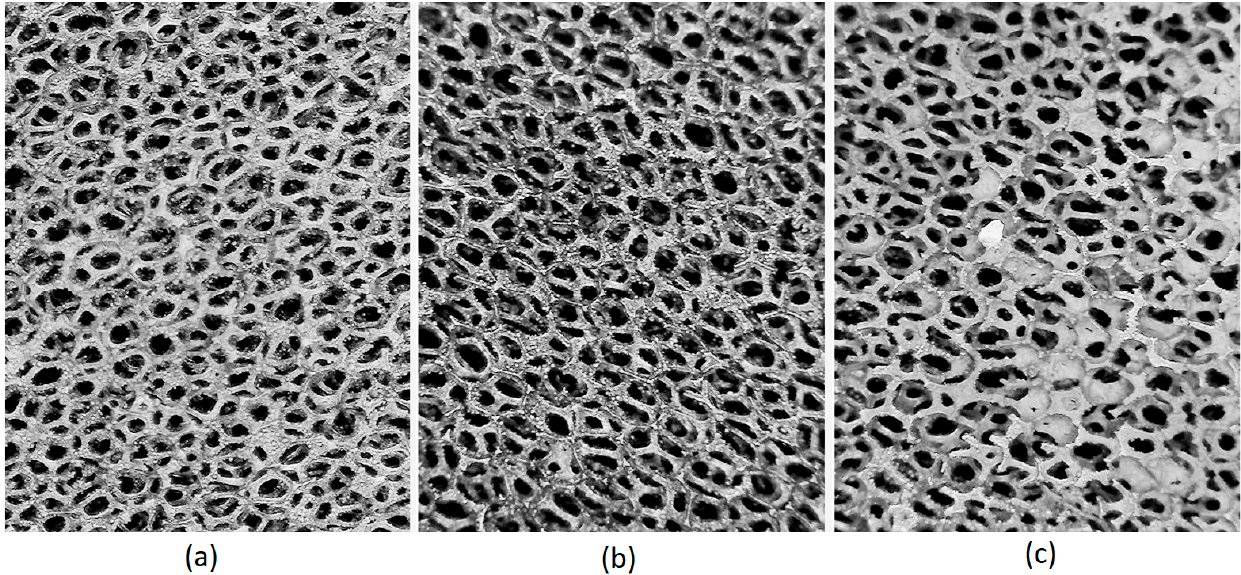
Figure 2. Mass and active phase content of catalysts at different stages of preparation: ( a ) single process with various solutions of NaMnO 4 ; ( b ) triple process with 5% and 10% solutions of NaMnO 4 (steps: 1—degreased and dried carrier, 2, 4, 6—impregnated and dried precursor, 3, 5, 7—calcined catalyst).